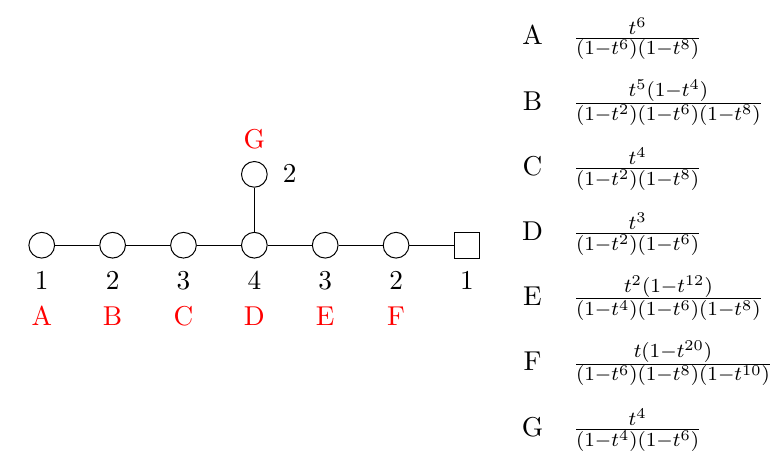
Table 18. E 7 family for k = 1 . B-twisted index with Wilson lines at the labelled position in the